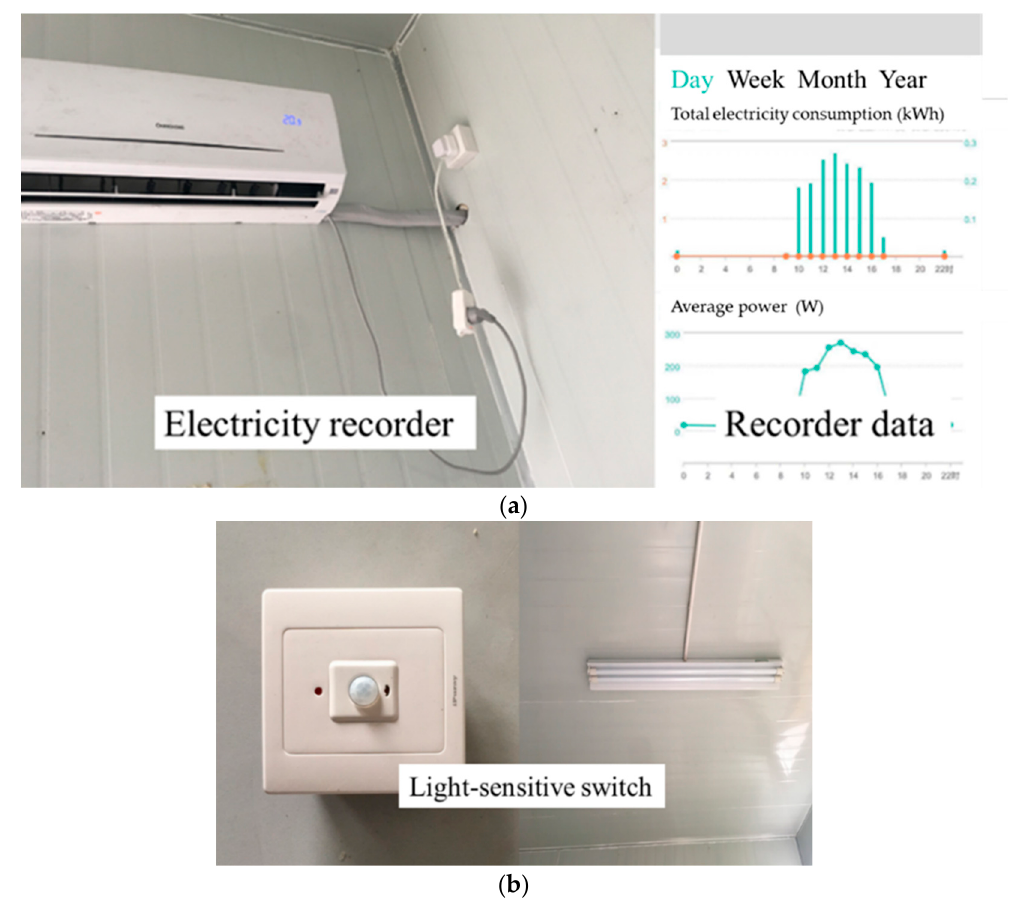
Figure 4. Energy saving test instruments for STPV modules, ( a ) air-conditioning electricity consumption recorder; ( b ) lighting electricity consumption recorder.